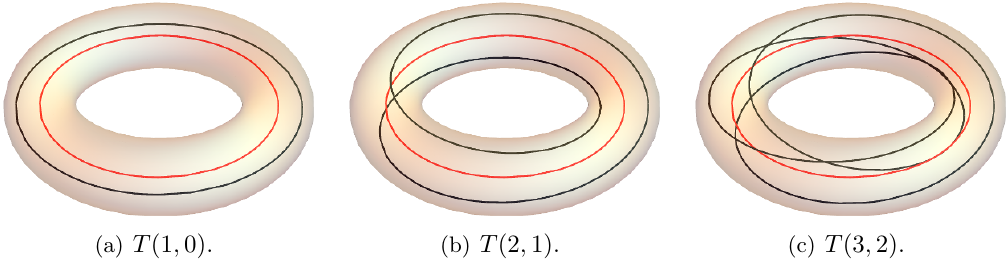
Figure 1 . Solid (cid:12)bered tori T ( q; t ). The central (cid:12)ber, shown in red, is exceptional if q > 1. Generic (cid:12)bers are shown in